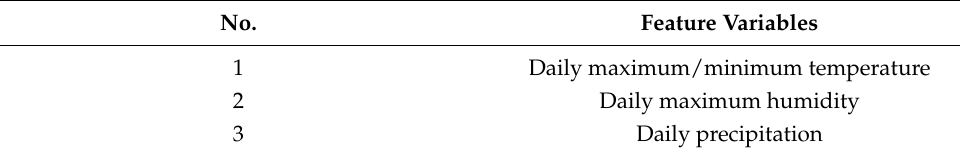
Table 2. Feature variables in the meteorological